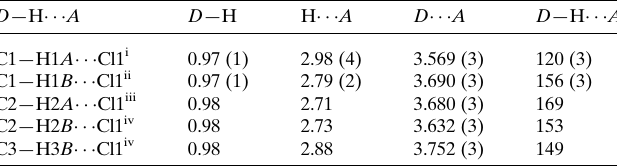
Table 1 Hydrogen-bond geometry (A˚ , (cid:4) ) for the monoclinic